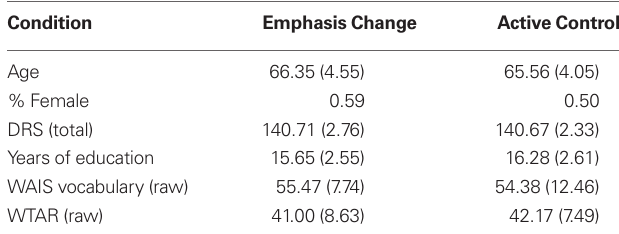
Table 1 | Mean values and standard deviations (in parentheses) of demographic information for participants in the Emphasis Change condition and the Active Control